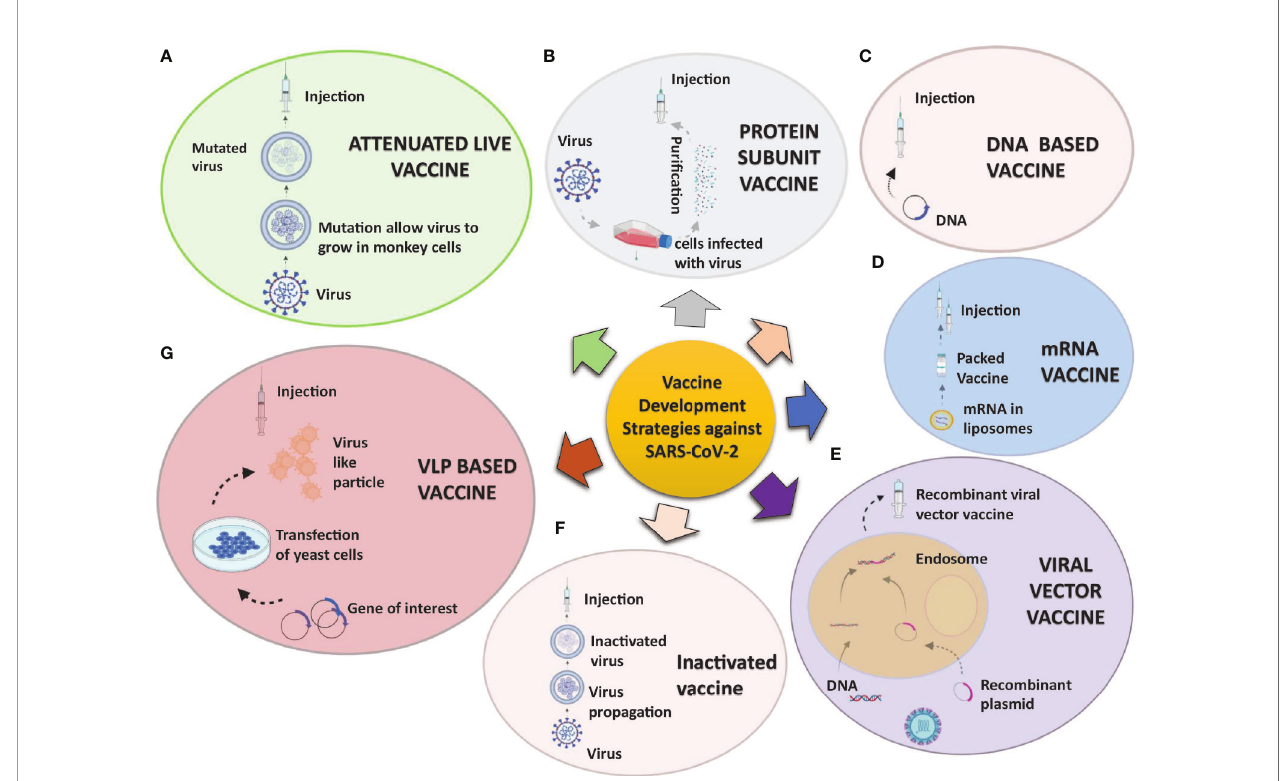
FIGURE 2 | Strategies being utilized to develop vaccine candidates against SARS-CoV-2: A concise overview of various aspects of the SARS-CoV-2 vaccine development process varying from traditional to novel platforms. (A) Attenuated live pathogen vaccine: A debilitated (infection incompetent) form of the live pathogen obtained by lengthy cell culture passaging in nonhuman cell lines or animals are administered. (B) Protein subunit vaccines are prepared from either antigen puri fi cation of pathogens replicated in cell cultures or recombinant expressed antigens. (C, D) Nucleic acid vaccines: mRNA (C) or DNA (D) codifying for an immunogenic protein of the pathogen express and present the antigen in antigen-presenting cells. The mRNA is mixed with nanoparticles or other stabilizing agents, and DNA is inserted in a vector. (E) Viral vector vaccines: Recombinant viral vectors are produced by genetic manipulation of measles or the adenoviral platform to express the antigen of interest. (F) Inactivated pathogen vaccines contain the whole pathogen that has been subjected to heat or chemical treatment for inactivation. (G) Virus-like particles vaccines: These are virus-like particles (20 – 200 nm) assembled and released by many baculoviruses or the mammalian expression system, e.g., recombinant yeast cells, vaccinia virus expression system, or even tobacco plants transfected with tobacco mosaic virus